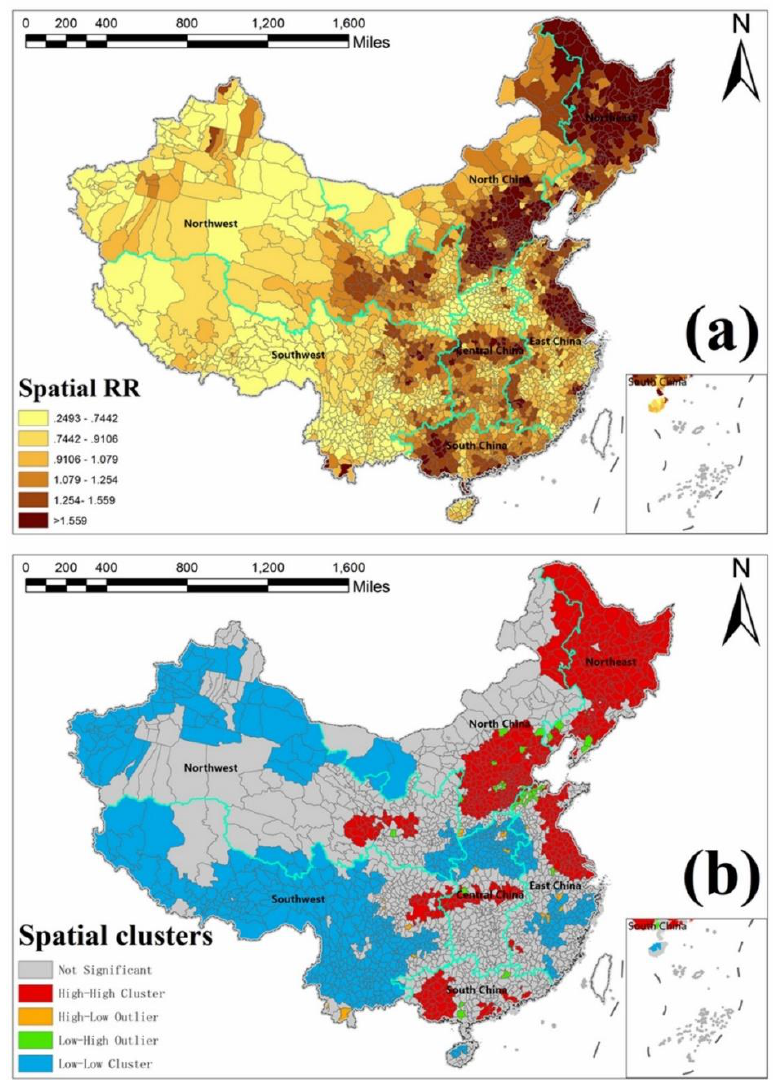
Figure 3. ( a ) Spatial structured relative risk ( RR ) map and ( b ) its cluster map of HFMD in Mainland China.